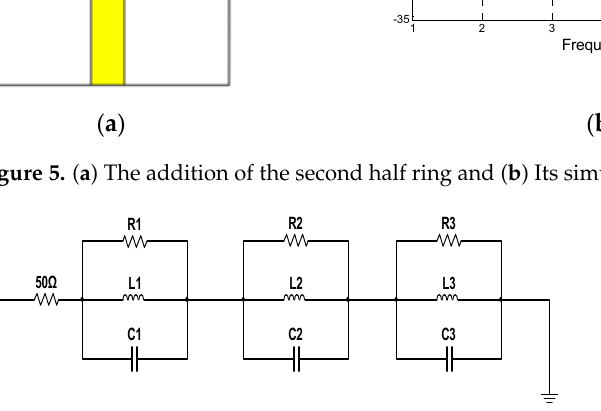
0.091 pF 0.091 pF